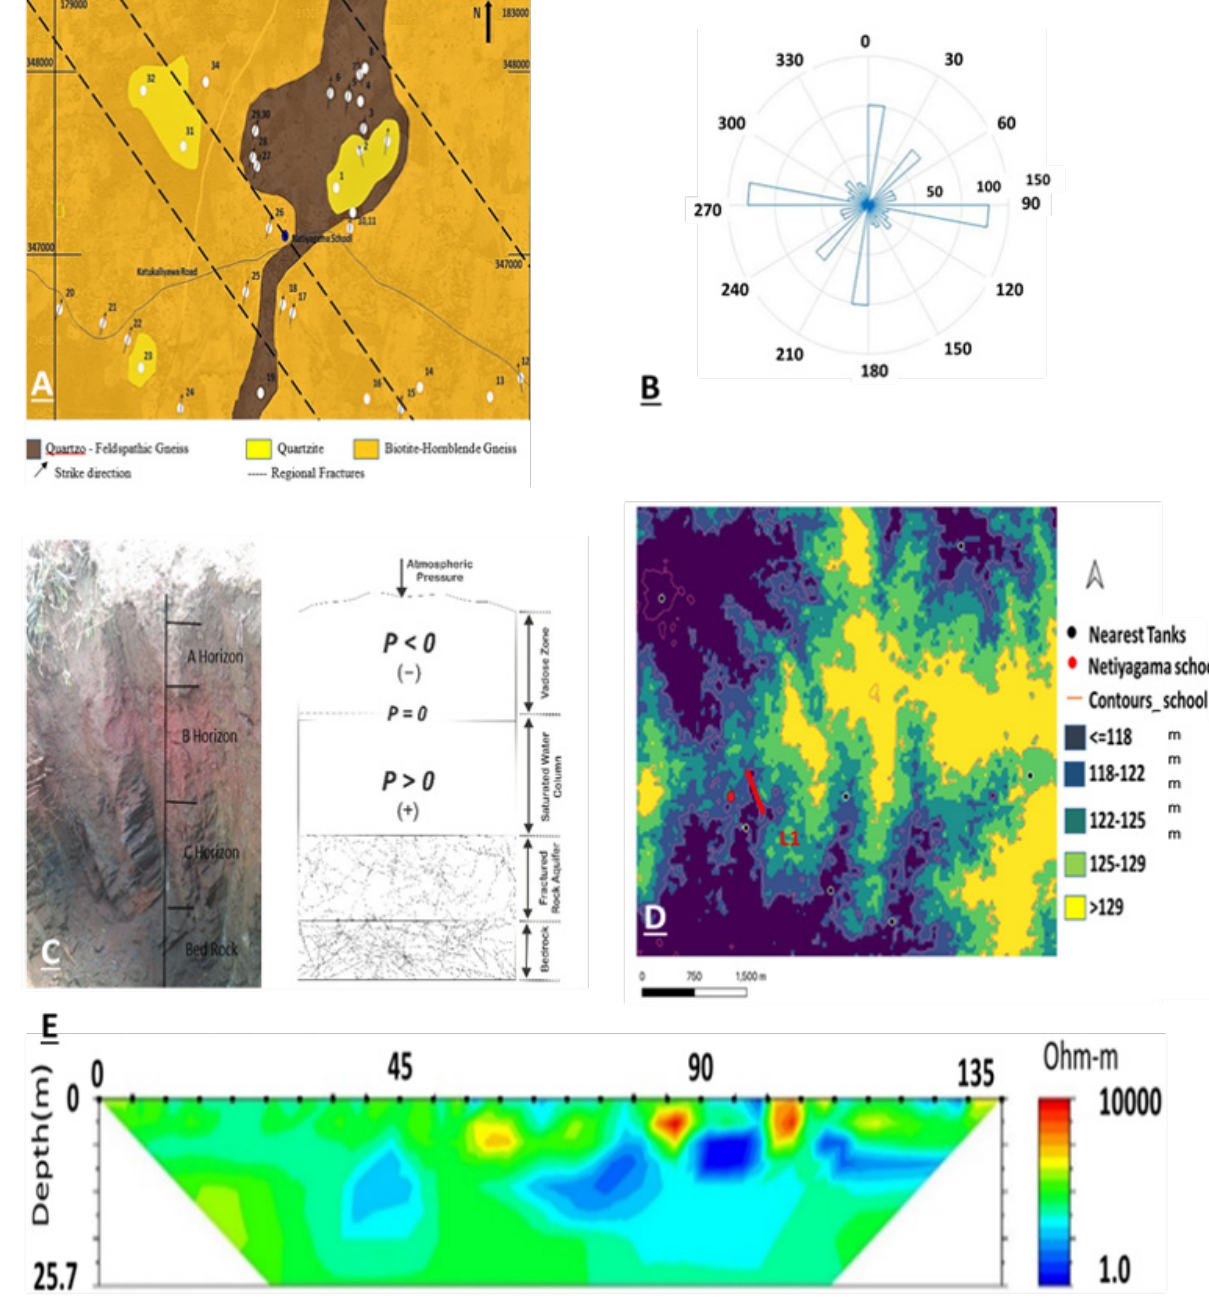
Figure 2: A.Geological map of 20 km 2 area B. Soil profile data with aquifer types C. Rose diagram of fracture patterns. B. The digital elevation map of Nettiyagama. The red dot indicates the source water location. C. Resistivity profile of Nettiyagama well (L1 line. Figure